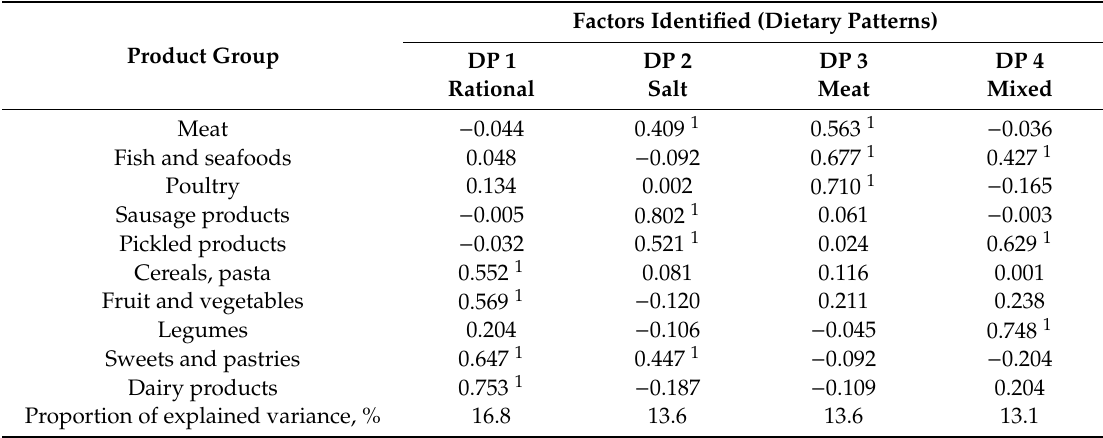
Table A7. Factor loadings of the principal dietary patterns identified (Krasnoyarsk Territory).